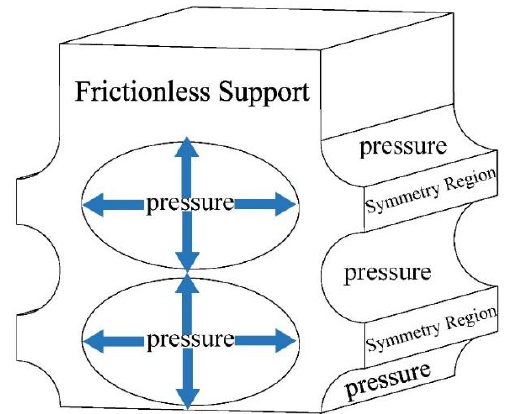
Figure 2. Strength analysis model and boundary condition setting.